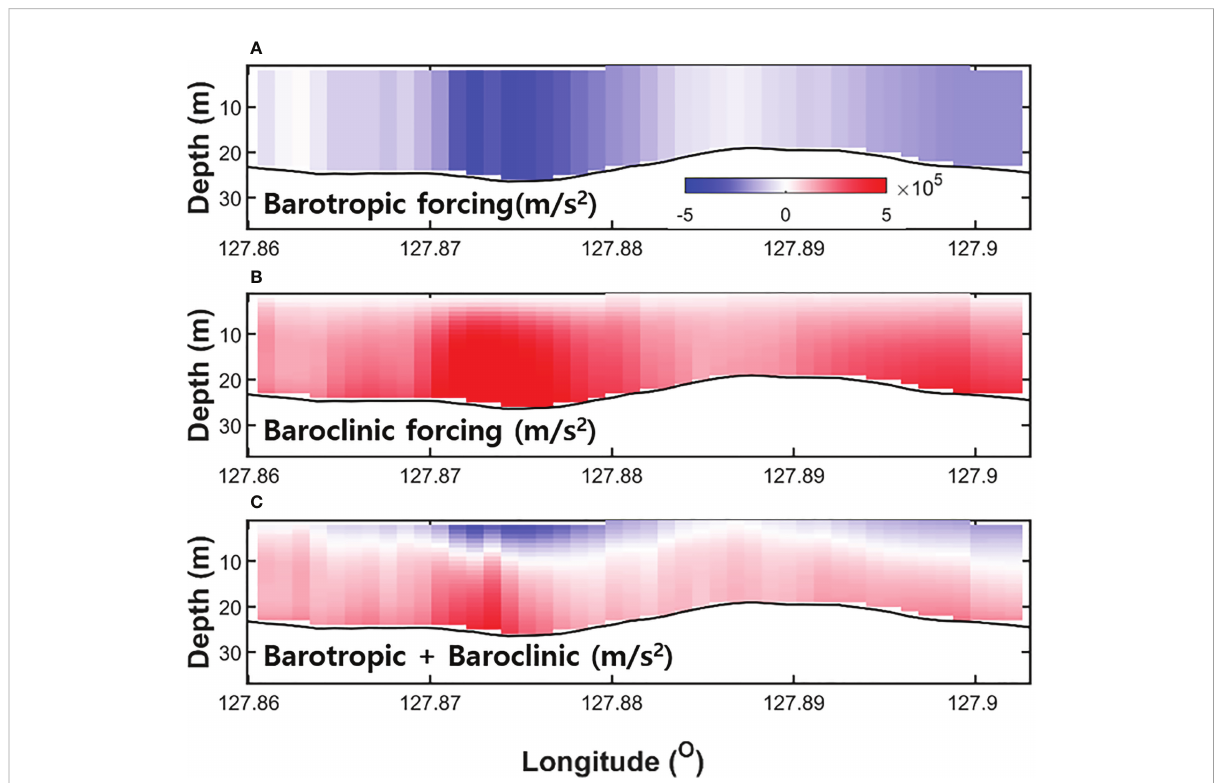
FIGURE 12 Vertical pro fi les of the (A) barotropic, (B) baroclinic, and (C) barotropic + baroclinic forces from the control experiment along Noryang Channel averaged from 26 June to 24